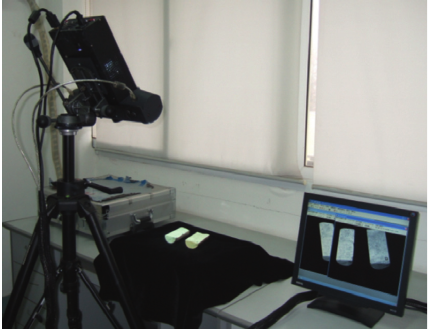
Figure 1: 3D scanner of the rock joint